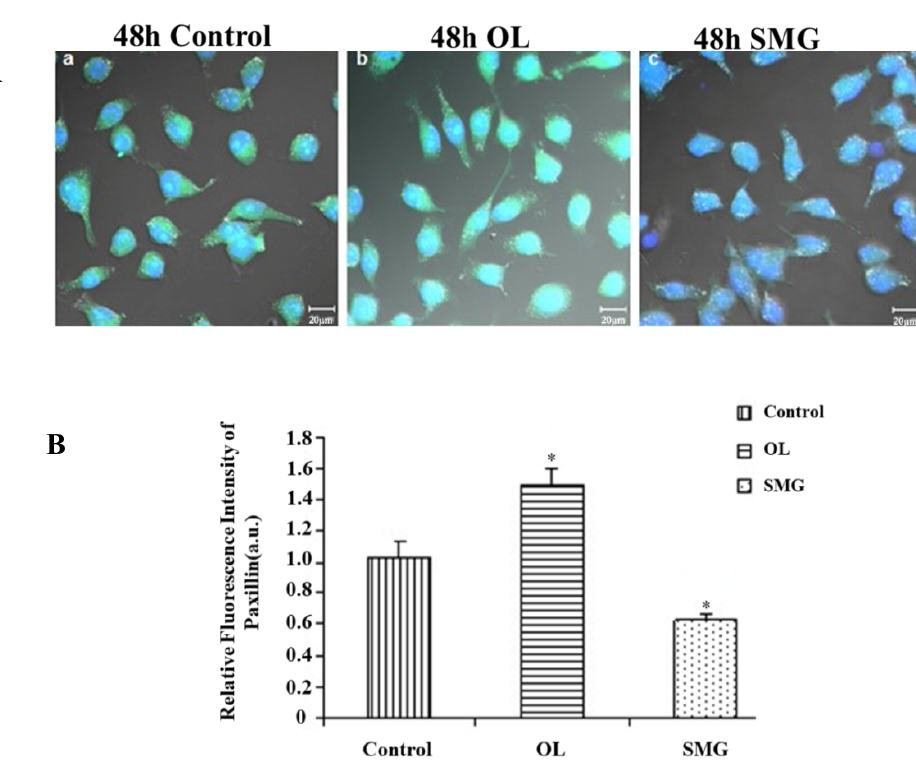
Figure 6. Expression of paxillin in MCF-7 cells after cell mechanics treatment. ( A ) The results of immunofluorescence experiments. The blue color indicates the nucleus, and the green color represents the paxillin protein. a. 48 h Control; b. 48 h Overload; c. 48 h SMG. ( B ) Relative fluorescence intensity of paxillin in MCF-7 cells after mechanical changes. * p < 0.05, significant difference; extremely significant.